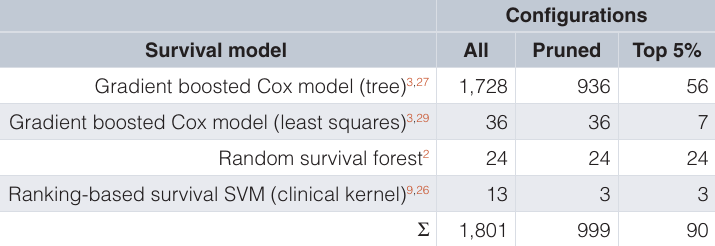
Table 2. Heterogeneous ensemble of survival models used in sub challenge 1a of the Prostate Cancer DREAM Challenge. All denotes the initial size of the ensemble, Pruned the size after pruning models with Harrell’s concordance index below 0.66, and Top 5% to the final size of the ensemble corresponding to the top 5 % according the combined accuracy and diversity score in Algorithm 2.